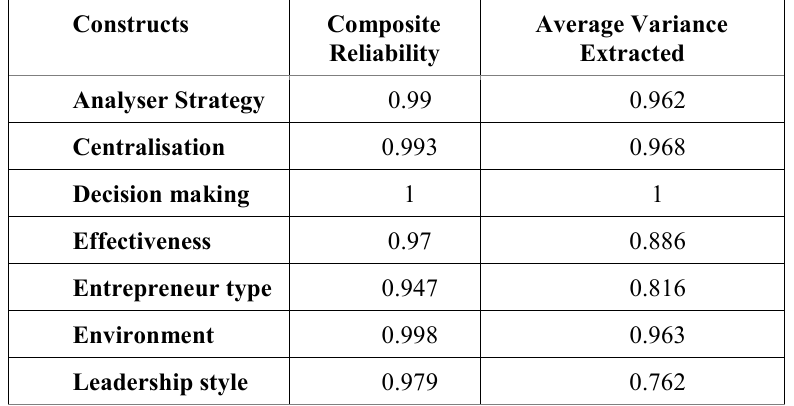
Table 2. Results of Measurement Model Convergent Validity